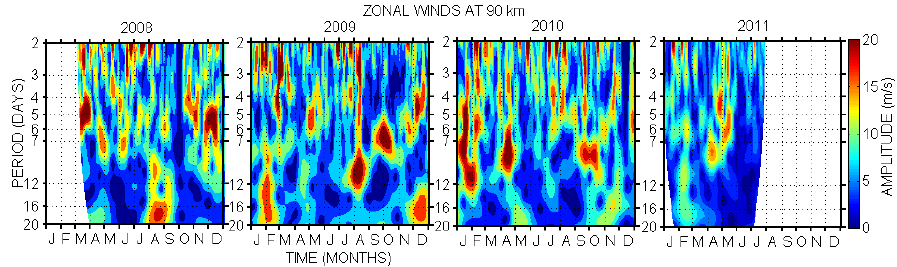
Fig. 5. A Wavelet analysis of hourly zonal wind amplitudes at heights of ∼ 90 km, over BLO from March 2008 to July 2011. 35